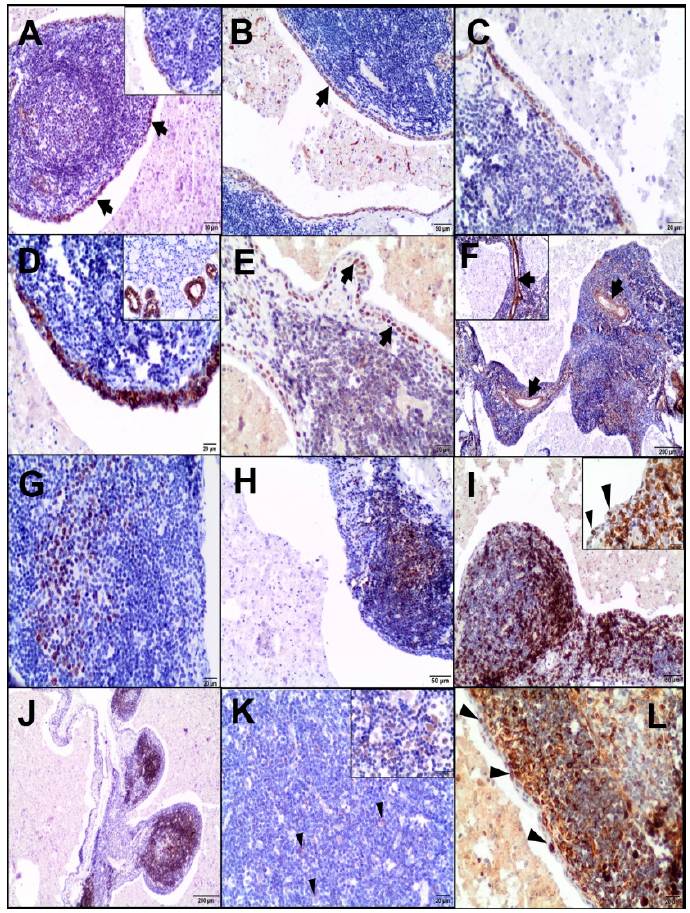
Figure 2. Immunohistochemical examination of the LEC. ( A ) Pan-CK-stained cytoplasm of the epithelial cells (arrows, inset, 400 × , scale bar = 20 µ m). Some pan-CK-positive reticulum cells in the background of the lymphoid tissue, 100 × ; scale bar = 50 µ m. ( B ) Basal epithelial cells of the cyst positive for the squamous di ff erentiation marker (CK5 / 6), 100 × ; scale bar = 50 µ m. ( C ) CK14 expression in the basal cells of the squamous epithelium, 200 × ; scale bar = 20 µ m. ( D ) CK19 stained the luminal epithelial cells, 200 × ; scale bar = 20 µ m. Inset: CK 19 expressed in ductal cells but absent in acinar cells of the salivary gland, 200 × ; scale bar = 20 µ m. ( E ) p63 expressed in basal cells of the squamous epithelium (arrows), 200 × ; scale bar = 20 µ m. ( F ) Vim stained connective tissue stroma and the blood vessel wall (arrows), 40 × ; scale bar = 200 µ m. Inset: α SMA-positive blood vessels, 100 × ; scale bar = 50 µ m. ( G ) Nuclear positivity for Ki-67 in the lymphoid follicles, 200 × ; scale bar = 20 µ m. ( H ) PCNA-positive cells in the germinal centre of the lymphoid follicles, 100 × ; scale bar = 50 µ m. ( I ) CD3-positive lymphocytes mainly in the peripheral region of the lymphoid follicles and interfollicular regions. 100 × ; scale bar = 50 µ m. Inset: CD3-positive intraepithelial lymphocytes (arrowheads), 400 × ; scale bar = 20 µ m. ( J ) CD79 α expressed in the marginal zone and less in the germinal centres, 40 × ; scale bar = 200 µ m. ( K ) A few CD68-positive macrophages (arrowheads), 200 × ; scale bar = 20 µ m. Inset: CD68 indicated by the cytoplasmic staining reaction, 400 × ; scale bar = 20 µ m. ( L ) Bcl-2 staining (mostly cytoplasmic and nuclear) mainly in the marginal zone of the lymphoid follicles and a few intraepithelial lymphocytes (arrowheads), 200 × ; scale bar = 20 µ m.